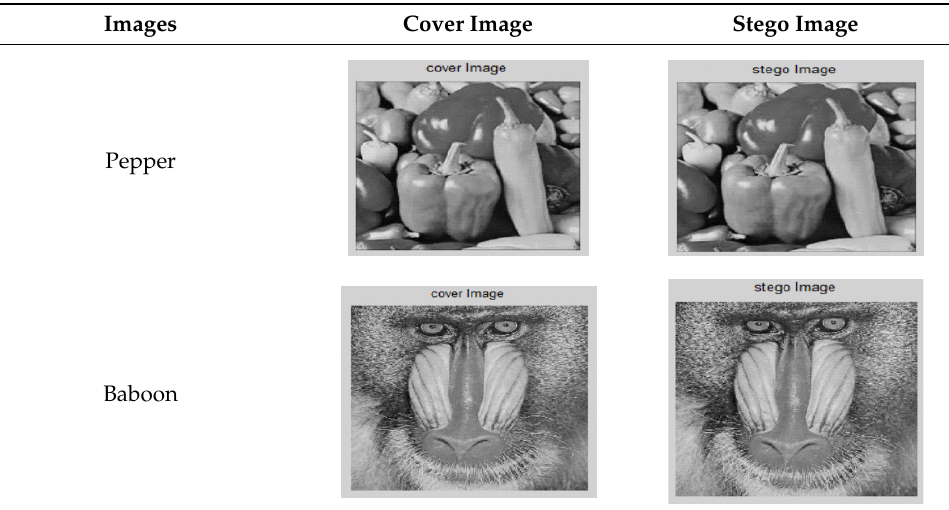
Table 2. The cover image and the respective stego images.